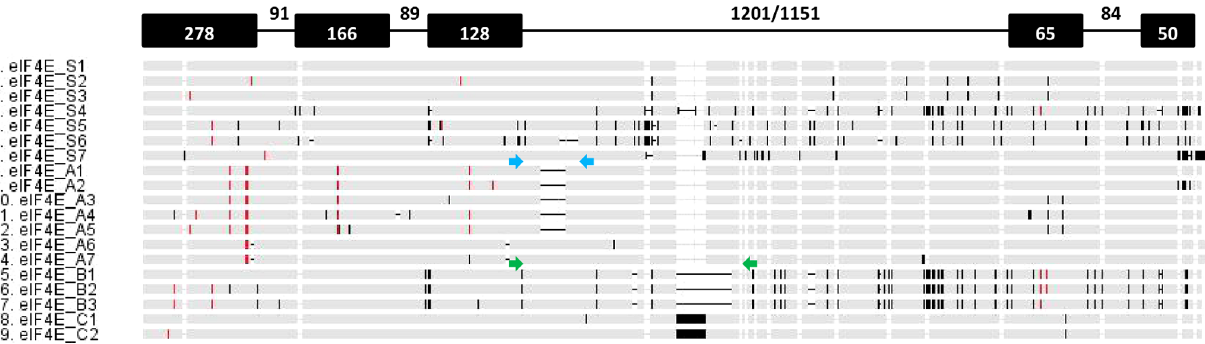
Figure 1. Schematic representation of sequence alignment of the all 19 identified protein eIF4E alleles. Four principal eIF4E variants identified by intron 3 polymorphism are designated A,B,C and S, while numbers indicate the respective allelic variant. Black bars indicate polymorphism nucleotides within both exons and introns, while red bars indicate polymorphism leading to amino acid exchanges. Horizontal lines indicate insertions/deletions. The heading line indicates nucleotide numbers and exon (solid black boxes)-intron (lines) positions and sizes. Blue arrows indicate primer A combination (Ps-eIF4E-750F and Ps-eIF4E-586gR) and green arrows indicate primer B combination (Ps-eIF4E-750F and Ps-eIF4E-1270R).